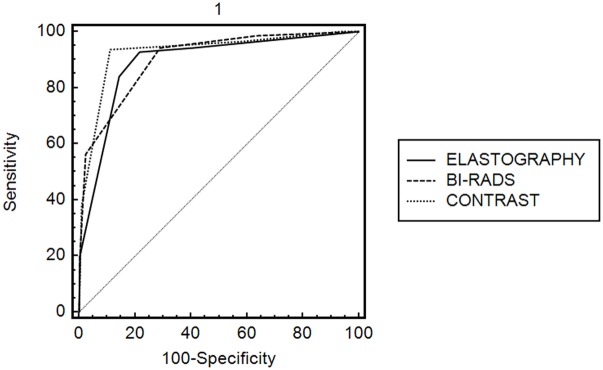
Comparison of ROC curve constructed for breast CEUS, elastography and BI-RADS.